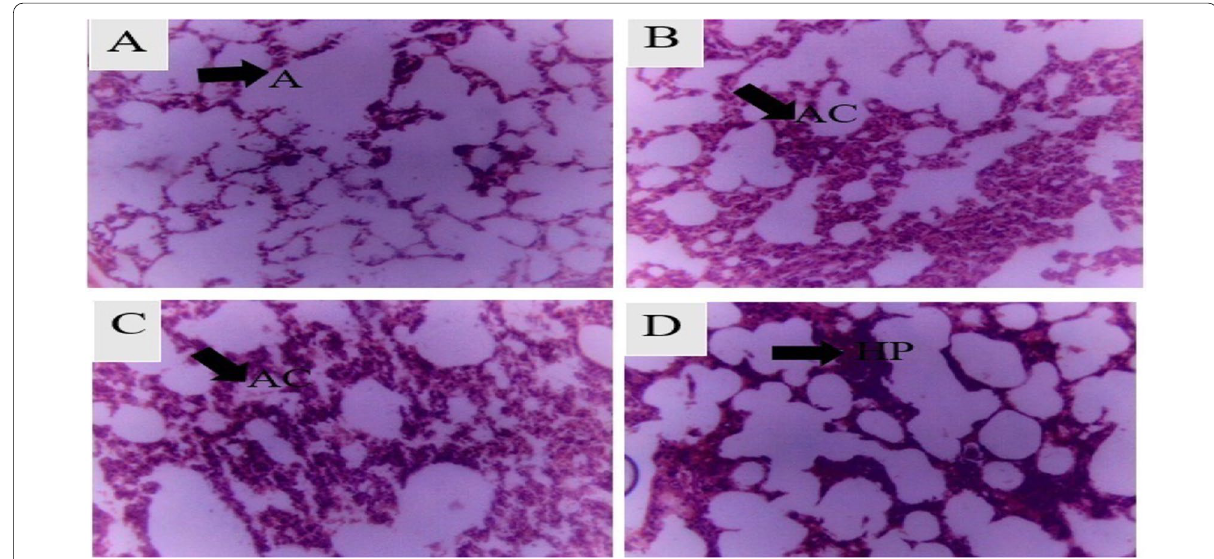
Fig. 5 Photomicrographs of lung sections of rats following 28-day oral administrations of Culcasia angolensis leaves extract (CAE) (haematoxylin and eosin-stained at 250 magnification). A Control (distilled water); B CAE (125 mg/kg); C CAE (250 mg/kg); D CAE (500 mg/kg), A (normal lung × alveoli); AC (slight alveoli congestion); HP (nuclei hardening and